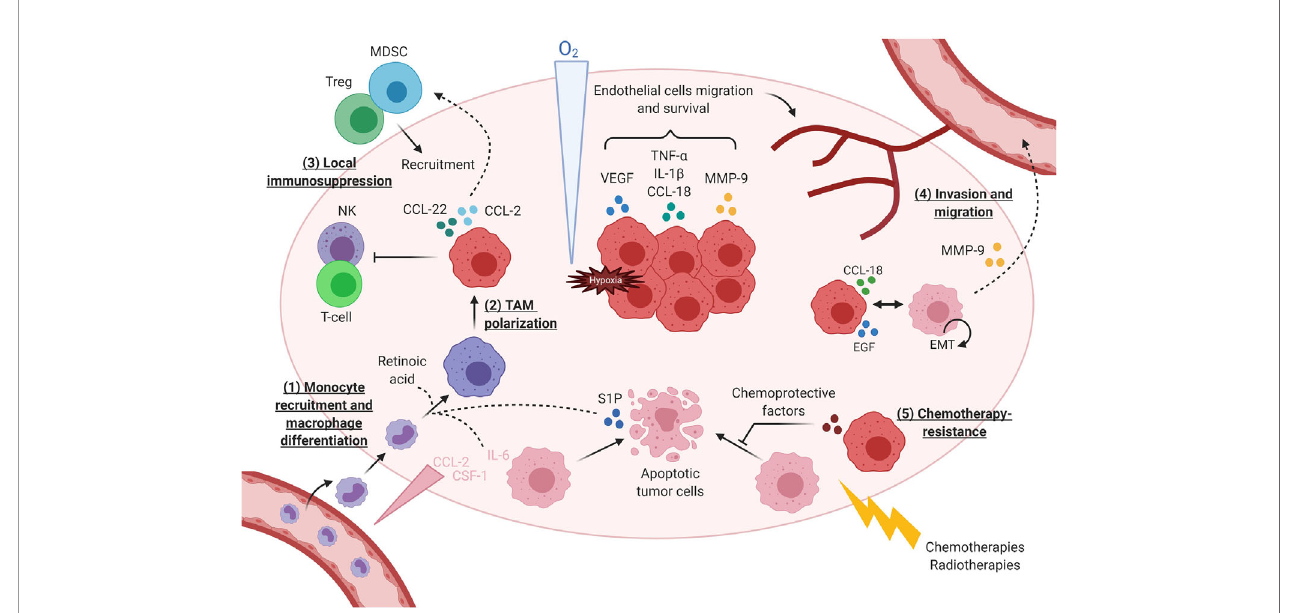
FIGURE 3 | TAMs execute diverse activities during tumor initiation and its immune escape. (1) Macrophages are fi rst recruited in tumor under the action of chemokines secreted by tumor cells. Some factors such as retinoic acid (113) and IL-6 (114) favor monocytes differentiation toward macrophages instead of dendritic cells. (2) Macrophages become TAMs with immunosuppressive activity, in particular due to sphingosine 1 phosphatase (S1P) released by dying tumor cells. (3) TAMs support local immunosuppression by: secreting immunosuppressive cytokines, inhibiting effector T-cells (115) and NK cells (116), recruiting Tregs though CCL22-CCR4 axis or MDSC through CCL2-CCR2. (4) Under hypoxia, macrophages produce various cytokines, including CCL-18 (117) triggered by tumor cells at the tumor invasive front, and proteases that induce EMT in tumor cells and favor their invasion and migration. Additional paracrine loops between tumor cells and TAMs, as described for EGF and CSF-1, amplify TAM-dependent cancer cell motility (94, 118). (5) Finally, TAMs contribute to anticancer treatment resistance by secreting factors protecting tumor cells from